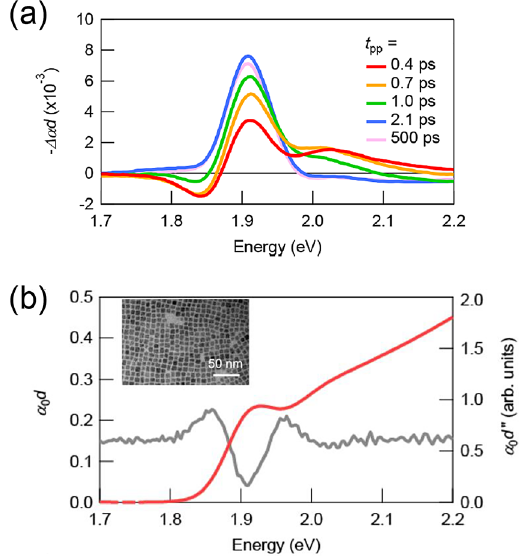
Figure 2: (a) The typical TA spectra of perovskite semiconductor nanocrystals. (b) The absorption spectrum and the corresponding second-order derivative of the same sample in (a). (a) and (b) Reproduced with permission [61]. Copyright 2018, American Chemical